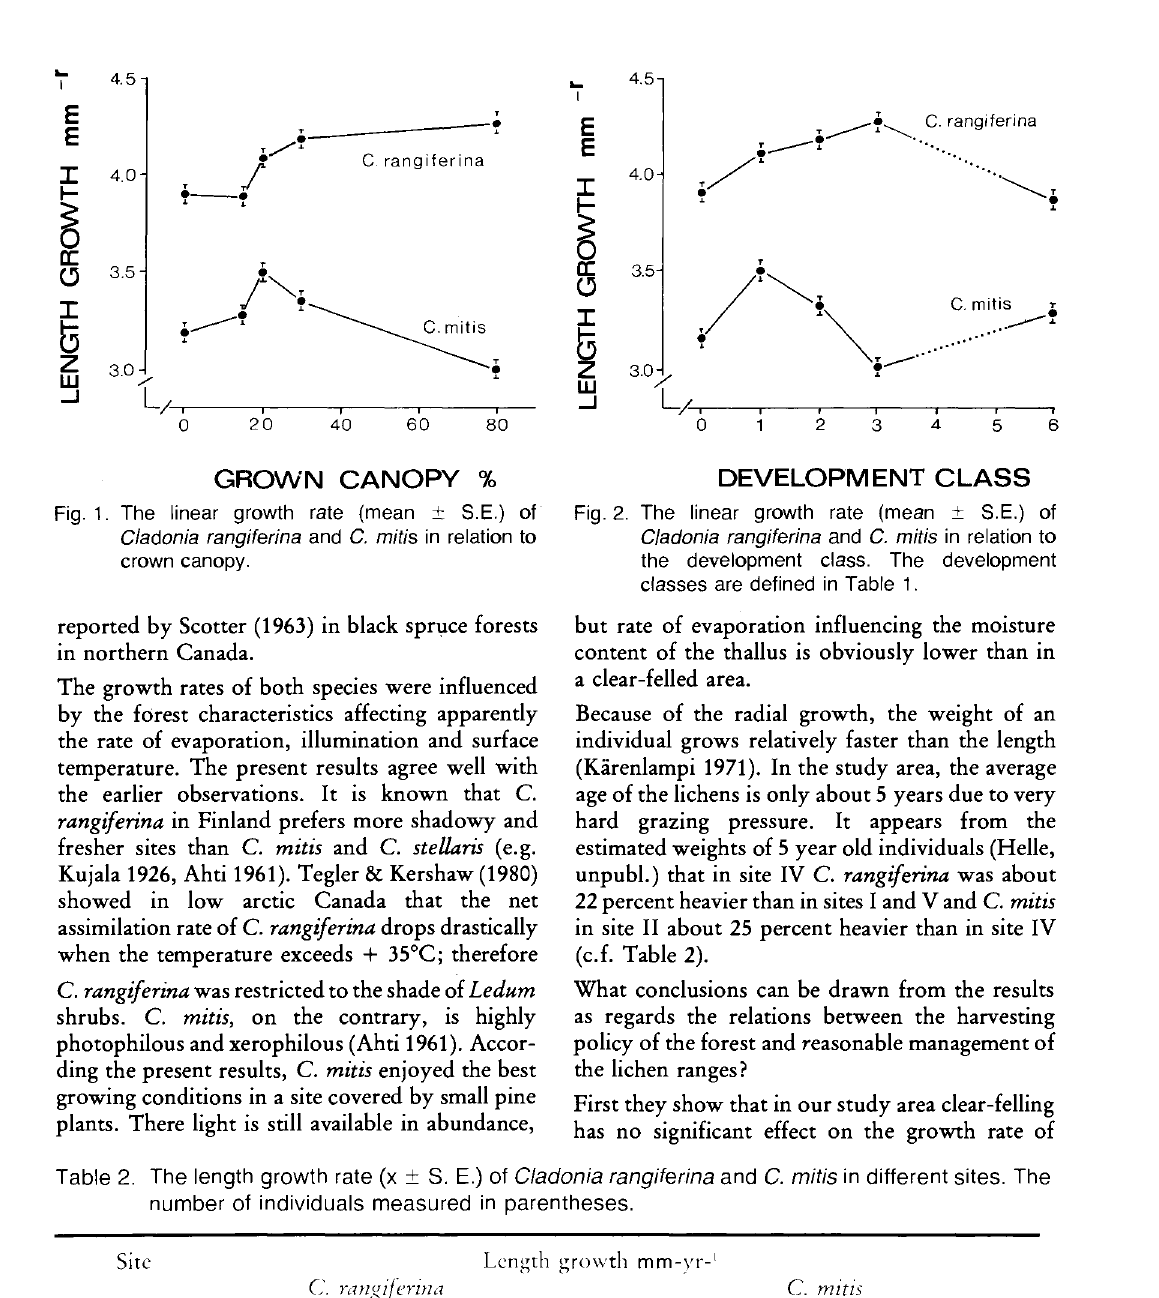
Table 2. The length growth rate (x ± S. E.) of Cladonia rangiferina and C. mitis in different sites. The number of individuals measured in